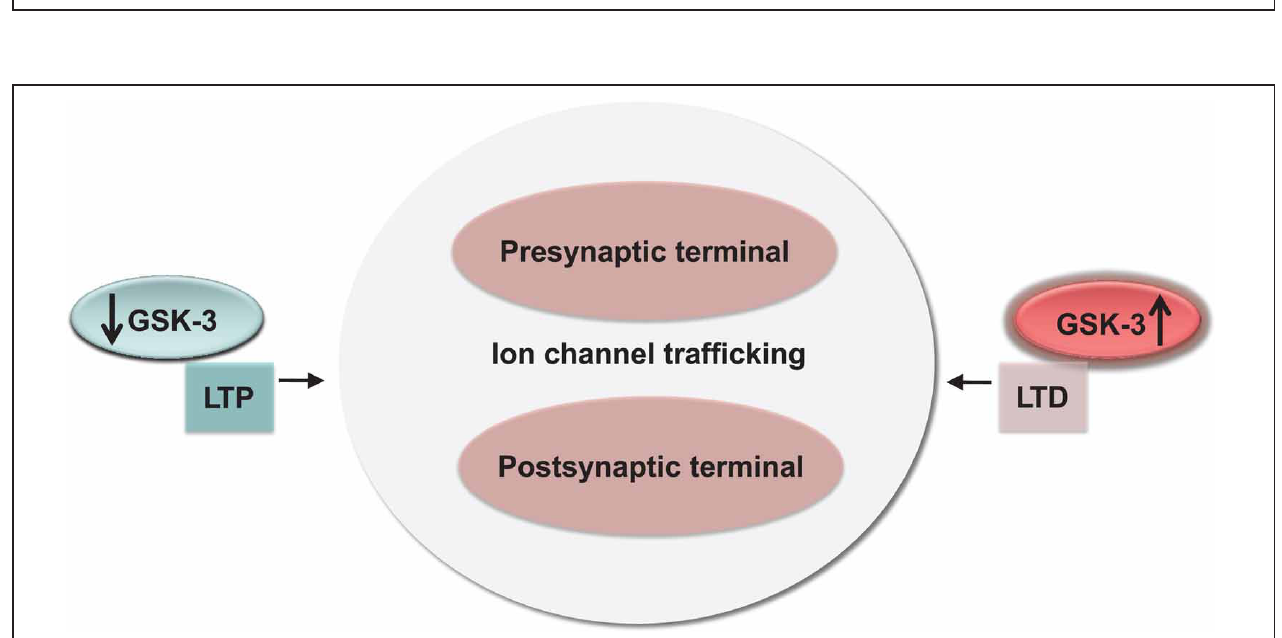
FIGURE 4 | Summary of ion channel targets of the GSK-3 pathway. The activity of GSK-3 is controlled by activation of insulin, TrK, and Wnt signaling through a cascade of positive downstream effectors including phosphatidylinositol 3-kinase (PI-3K), phosphatidylinositol (3,4,5)-triphosphate (PIP3), and 3-phosphoinositide-dependent protein kinase (PDK1).